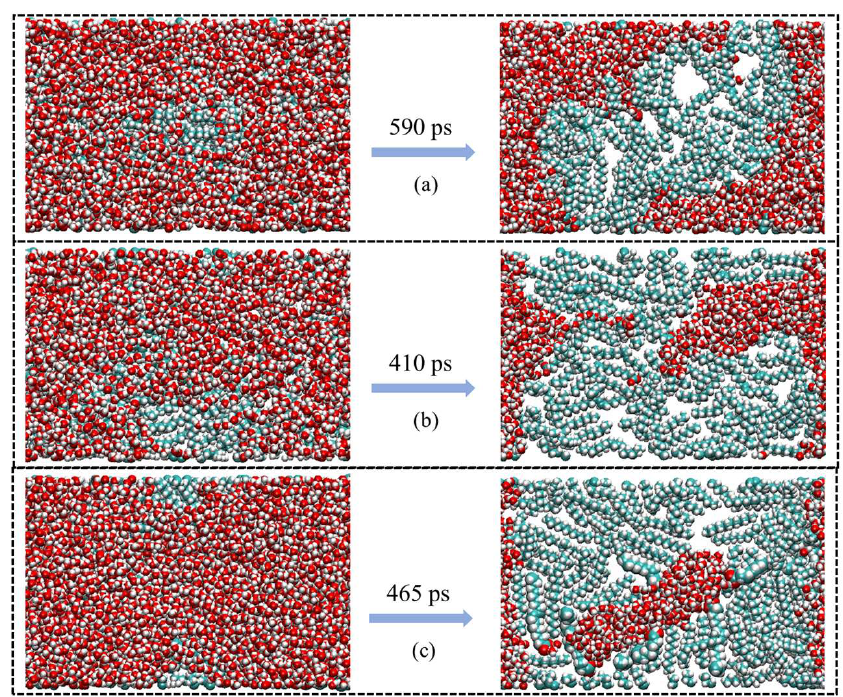
Figure 13. Structure of three-phase contact line of gas–liquid collector (gas is hidden) and merger time during the process of bubble and oil film merger of ( a ) OA:DD = 3:1, ( b ) OA:DD = 1:3, and ( c ) OA:DD = 1:6 (definition of the merger process: from the initial contact between the bubble and the oil film until the water molecules between the bubble and the oil film are not connected at all).